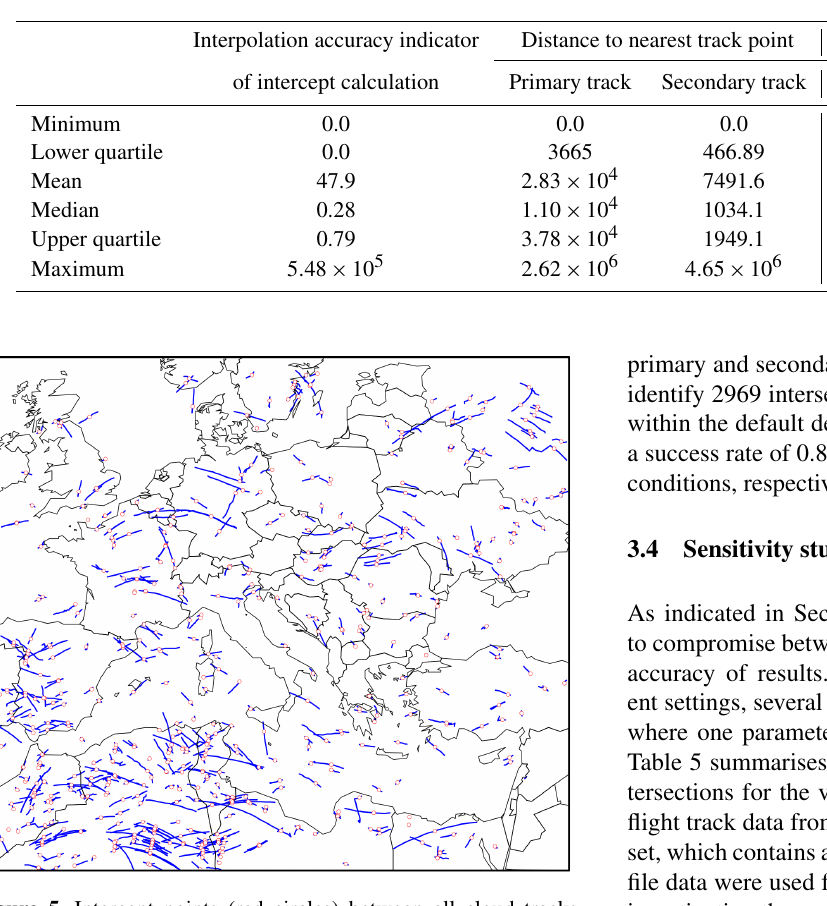
Figure 5. Intercept points (red circles) between all cloud tracks (blue lines) and the CALIPSO ground track (not shown) identified in the region spanning from 16.5 ◦ W, 28.7 ◦ N to 34.3 ◦ E, 59.8 ◦ N during